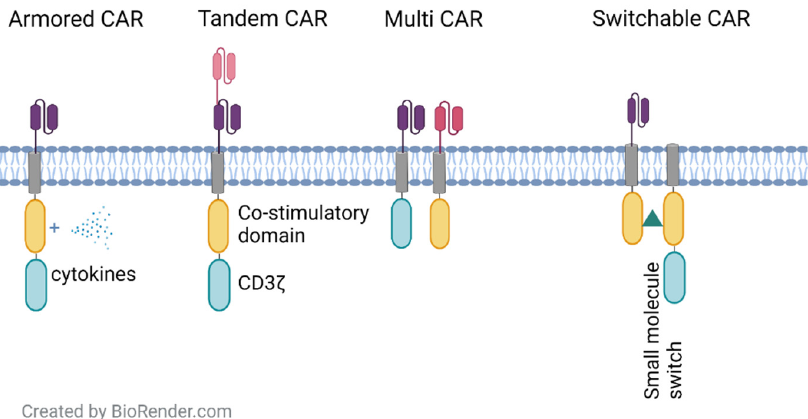
Figure 2. Various CAR constructs aimed at overcoming the loss of antigen and tumor